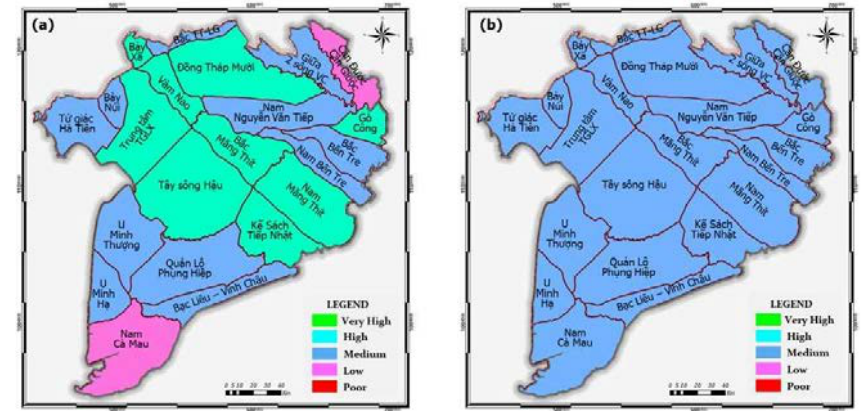
Fig. 4: Maps showing the overall water security index of (a) the environment and ecosystem dimension and (b) the water governance dimension for each subregion in 2018